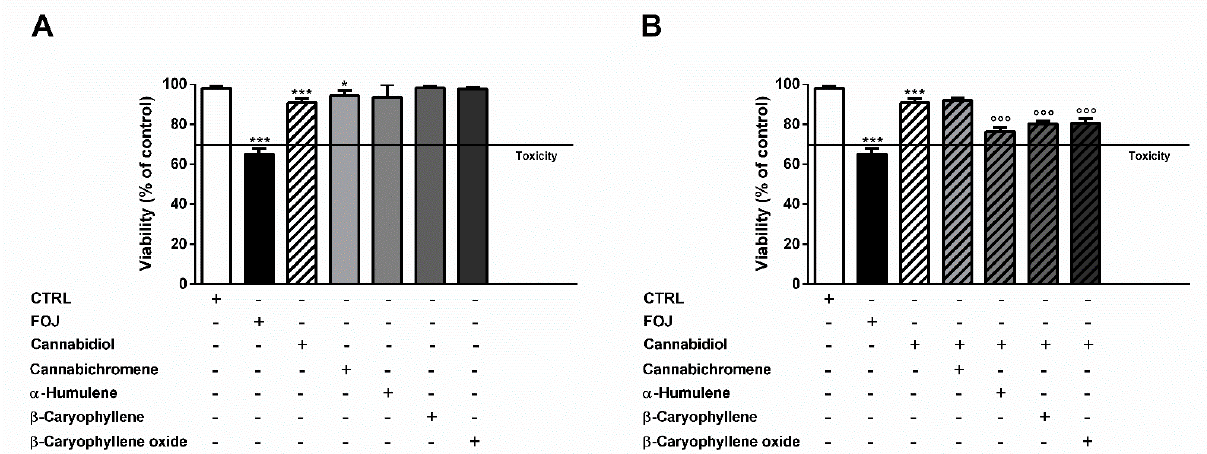
Figure 2. ( A ) Cytotoxicity of 50 µ g/mL FOJ (organic extract from the inflorescences of Cannabis sativa var. Felina 32 collected in June), and of nonintoxicating phytocannabinoids (4 µ g/mL cannabidiol, 0.2 µ g/mL cannabichromene) and caryophyllane sesquiterpenes (0.05 µ g/mL α -humulene, 0.05 µ g/mL β -caryophyllene, and 0.03 µ g/mL β -caryophyllene oxide), at the corresponding concentrations determined in the extract by GC-MS analysis, in MDA-MB-468 after 24 h exposure. ( B ) Cytotoxicity of 4 µ g/mL cannabidiol alone and in combination with cannabichromene (0.2 µ g/mL), α -humulene (0.05 µ g/mL), β -caryophyllene (0.05 µ g/mL), and β -caryophyllene oxide (0.03 µ g/mL) in MDA-MB-468 after 24 h exposure. Data are expressed as mean ± SEM of at least three independent experiments with three technical replicates ( n = 9); * p < 0.05 and *** p < 0.001, significant difference respect to the control; ◦◦◦ p < 0.001, significant difference respect to cannabidiol (ANOVA + Dunnett’s Multiple Comparison PostTest).